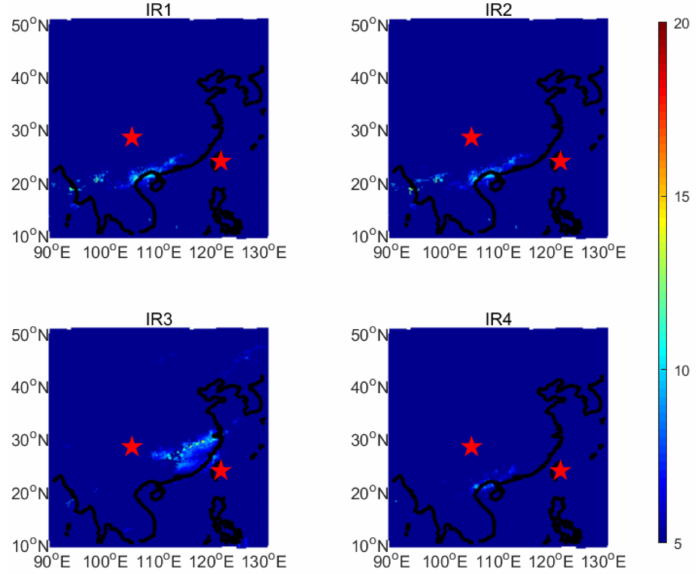
Figure 13. Power spectrum images on 8 December